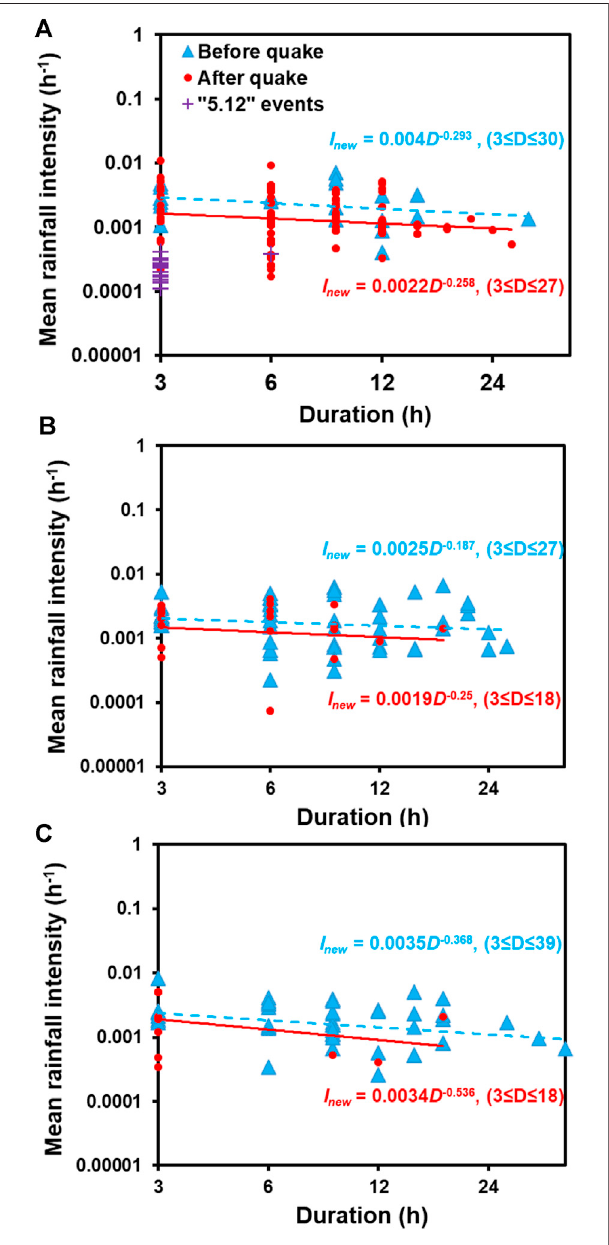
FIGURE 4 | I-D curves for debris fl ows. The blue and red lines indicate I-Dcurvesfordebris fl owsbeforeandaftertheWenchuan (A) ,Lushan (B) ,and Jiuzhaigou (C) earthquakes. In the WEA, the pre-quake I-D curve is fi tted with 21 debris- fl ow events from 2000 to 2007, while post-quake one is fi tted with183events from2008to2010when excluding thesamples ontheday of “ 5.12 ” earthquake.Theredcircledenotesdebris fl owsoccurringafterMay12, 2008, while the purple cross represents the debris fl ows occurring on that day. All sample points and fi tted curves are drawn in the double logarithmic coordinate